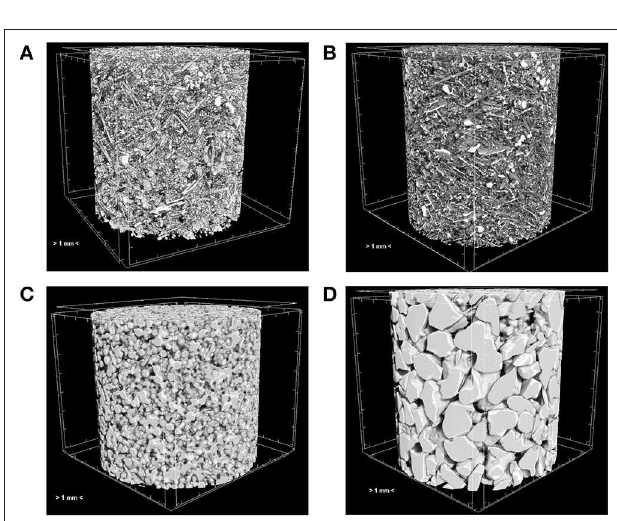
TABLE 1 | 3D µ CT morphometric